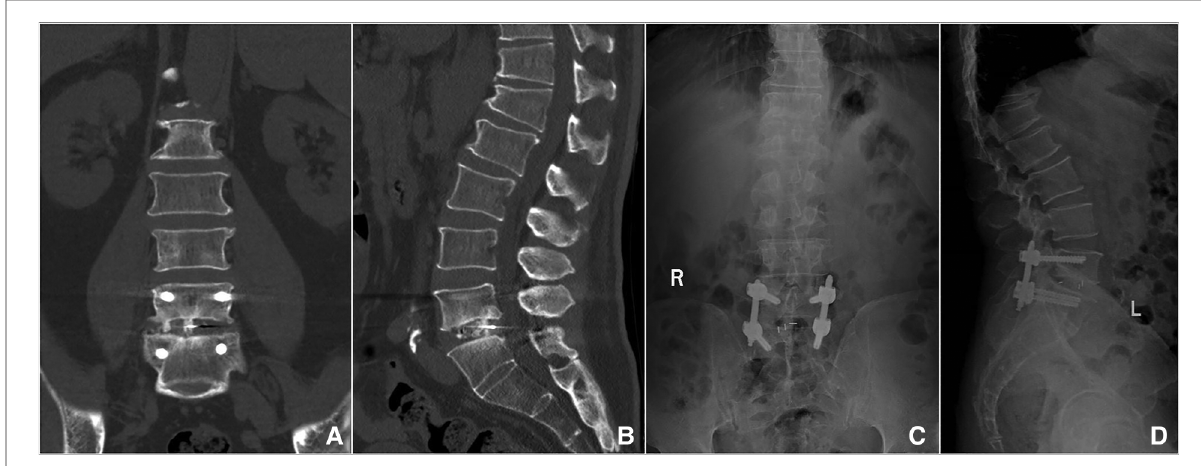
FIGURE 4 Imaging fi ndings during postoperative follow-up. ( A,B ) Coronal and sagittal CT showed that the cage was well positioned and high-density bone fusion between vertebral bodies at 6 months postoperatively. ( C,D ) A 14-month postoperative x-ray showed bony fusion and the instrumentation was in a good